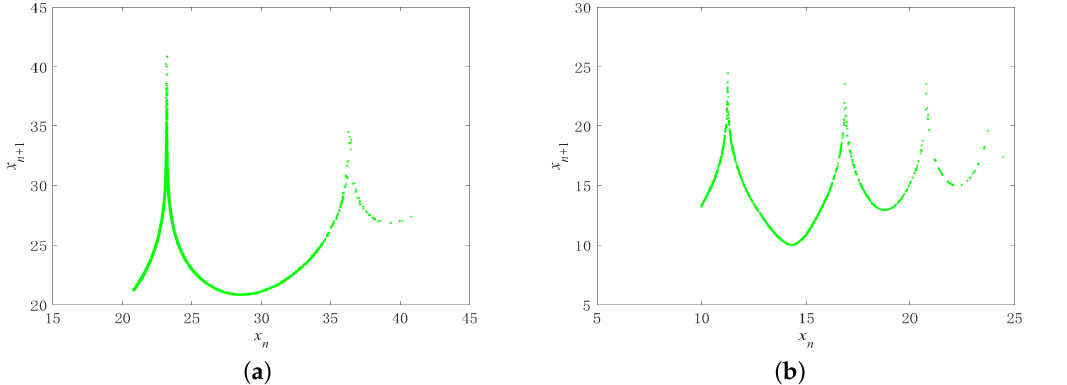
Figure 13. First return map of system (1) under different parameters: ( a ) Poincaré section z = − 9.1503, ( a , b , c , k ) = ( 10,100,11.2, − 0.2 ) ; ( b ) Poincaré section z = 0, ( a , b , c , k ) = ( 10,64,0,0 )